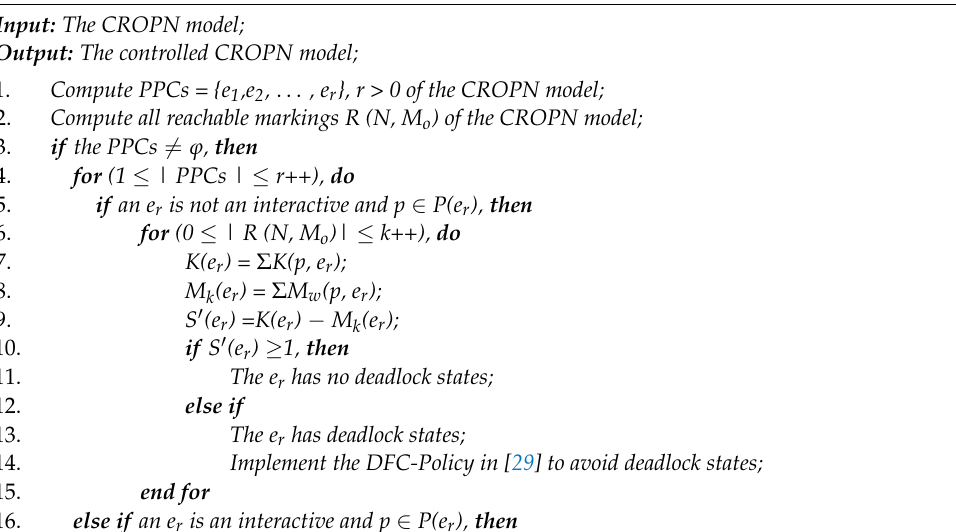
Algorithm 1 Policy for avoiding deadlock in the